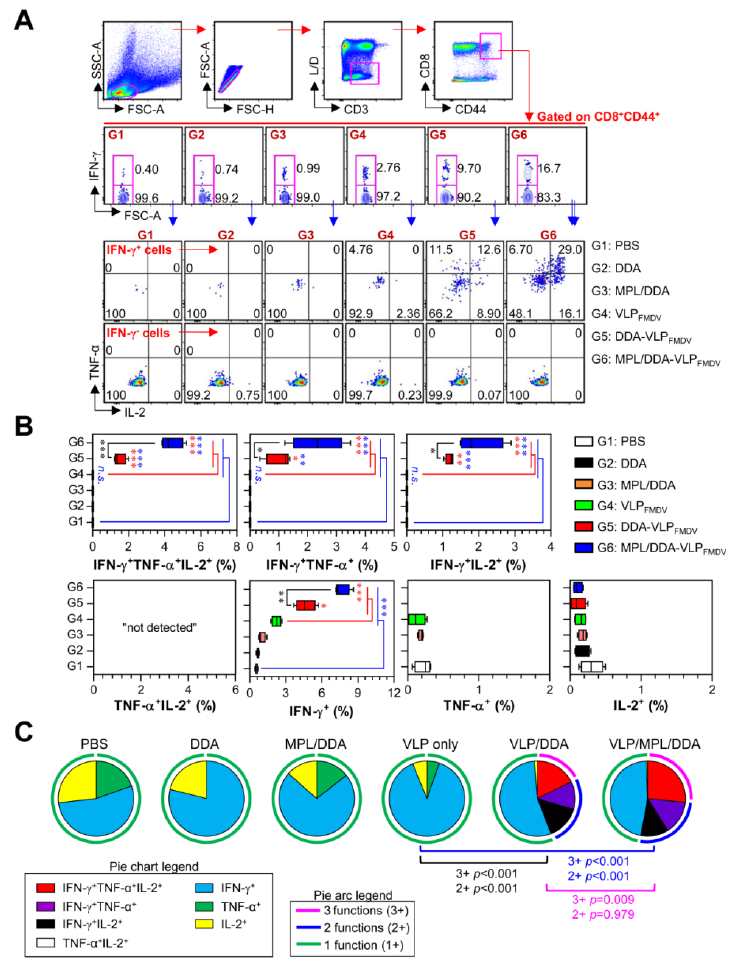
Figure 4. Analysis of antigen-specific multifunctional CD8 + T cells. ( A ) Gating strategy for multifunctional CD8 + memory T cells. ( B ) Percentage of VLP-specific total cytokine (IFN- γ, TNF - α, and/or IL-2)-producing cells among splenic CD8 + CD44 + memory T cells. ( C ) Pie charts represent the mean frequencies of cells co-expressing IFN- γ, TNF - α, and/or IL -2. The relative amounts of single-, double- and triple-functional CD4 + CD44 + memory T cells are indicated as pie arcs. The means ± SD ( n = 5 mice / group) shown are representative of two independent experiments. * p < 0.05, ** p < 0.01, *** p < 0.001. n.s.: not